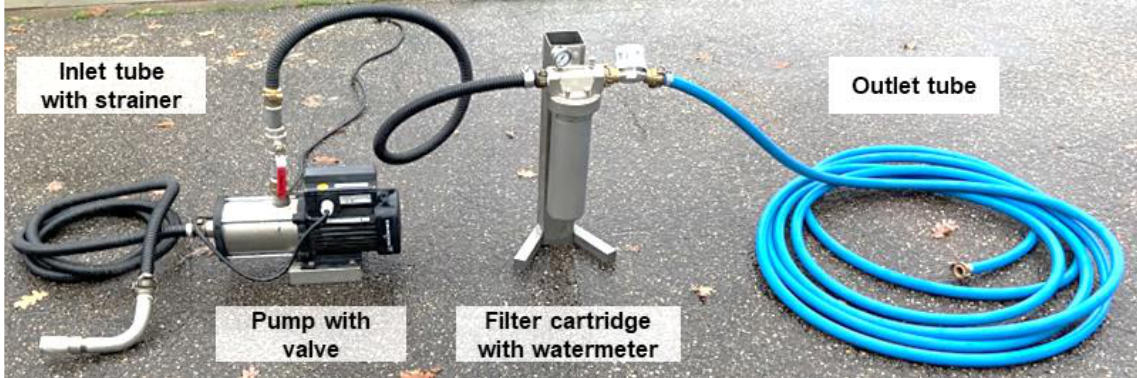
Figure 2. Setup for sampling microplastics in water bodies.